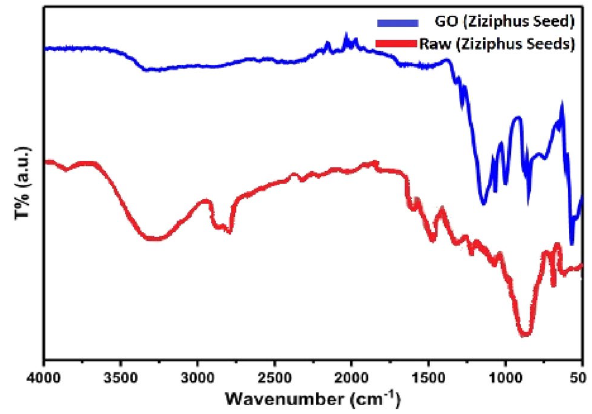
Figure 5. IR-spectra for GO- ziziphus Seeds.